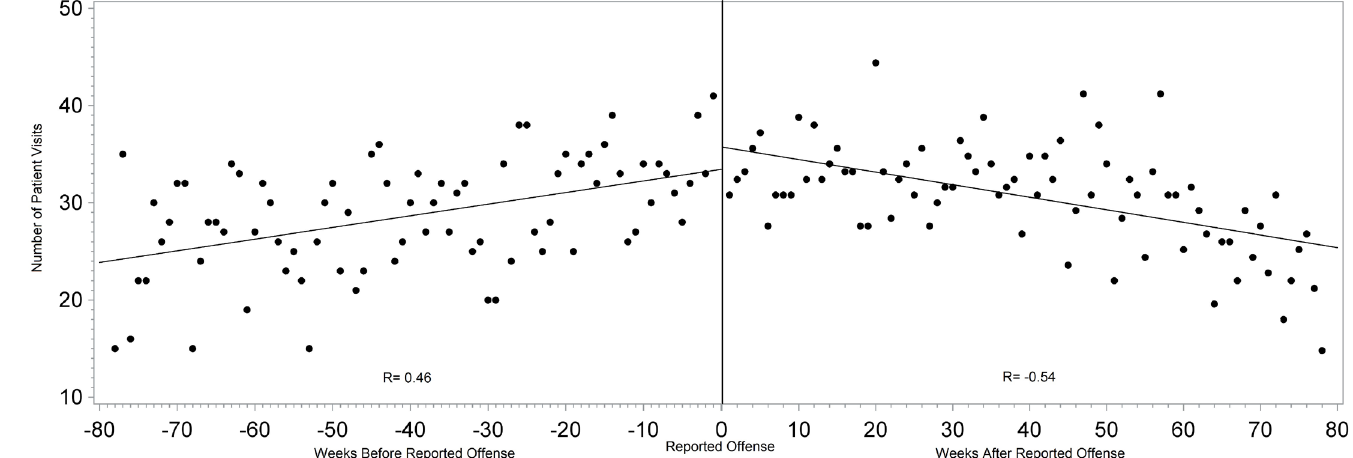
Figure 1. Correlation between number of all healthcare visits and the time from each intimate partner victim’s reported date of offense.